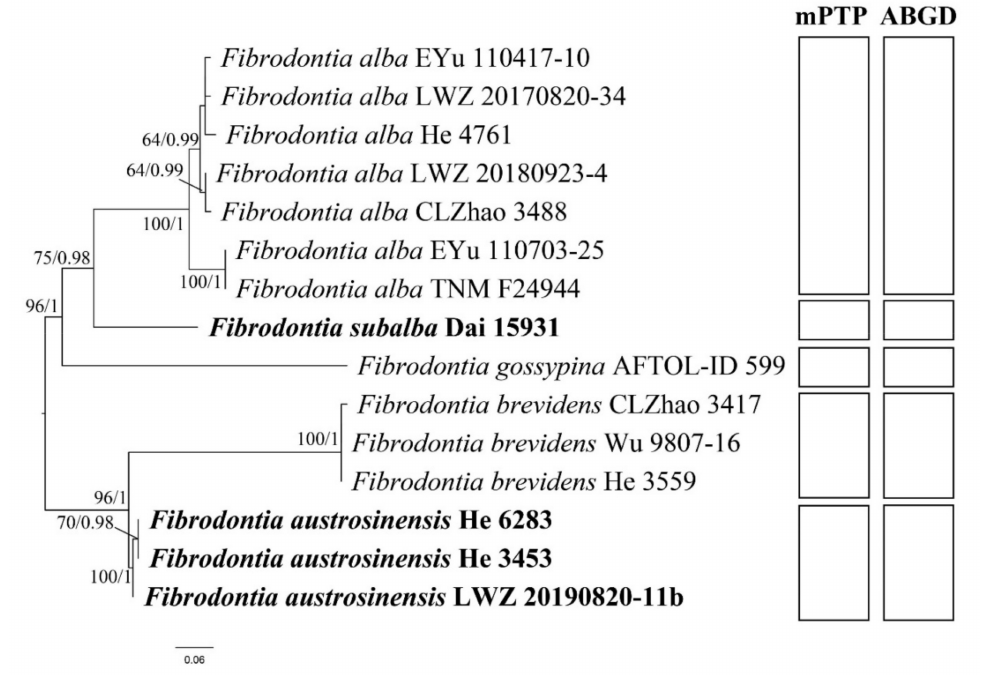
Figure 3. Phylogenetic relationship of species within Fibrodontia inferred from the data set of ITS region. The topology is from maximum likelihood analysis. Bootstrap values and Bayesian posterior probabilities, if simultaneously above 50% and 0.8, respectively, are labelled at the nodes. The newly described species are in boldface. Species delimitation indicated by rectangles was inferred using the multi-rate Poisson Tree Processes (mPTP) and the Automatic Barcode Gap Discovery (ABGD)